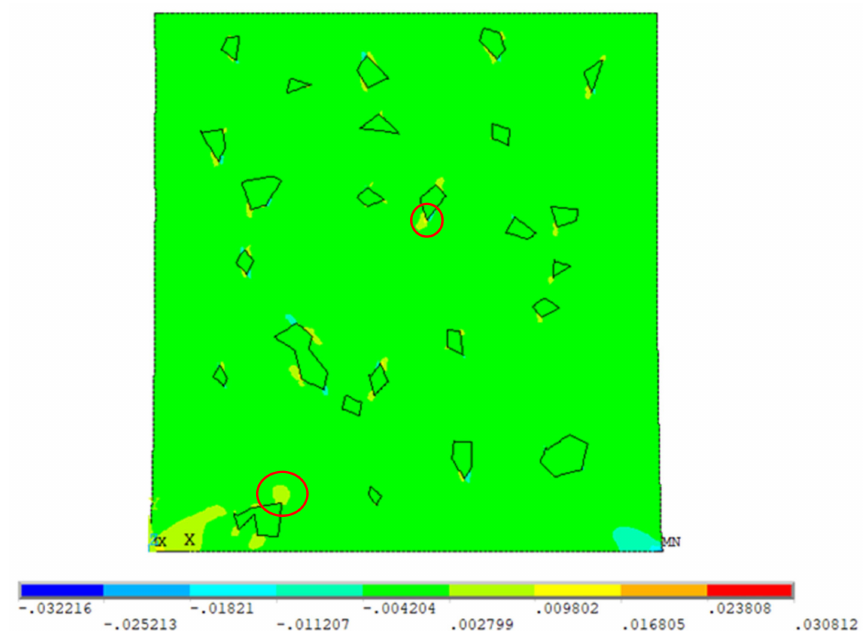
Figure 13. The shear plastic strain (%) of RVE 2. The red circles represent strain